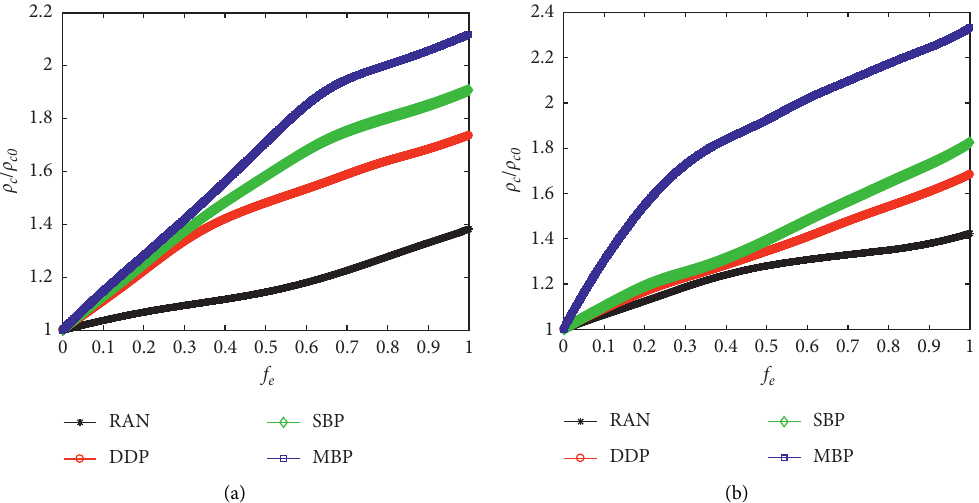
Figure 3: The enhancement of our strategies in multiplex network: (N) � 128, (m) � 4, < (k) > � 32, and (Z) and (b) (Z) in � 28.